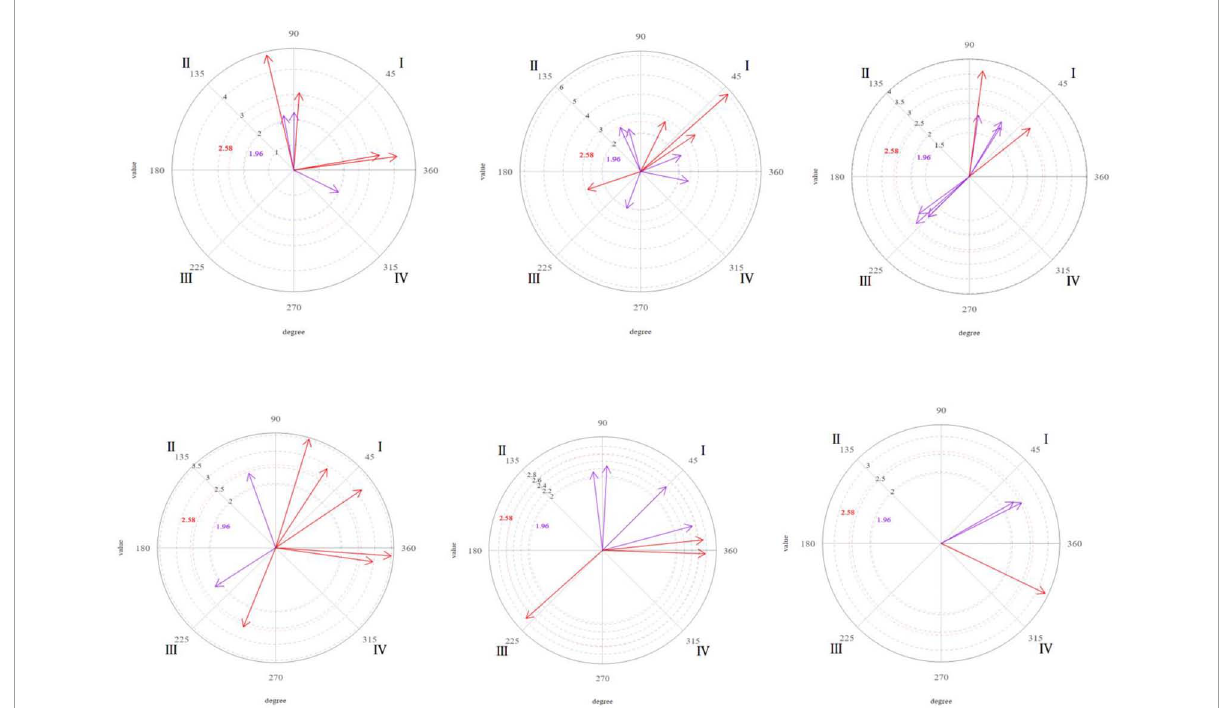
FIGURE1 Graphic representation of the significant (purple) and very significant (red) vectors obtained in the polar coordinate analysis. Focal behavior “Verbalizes” as the center of the analysis and all the others as conditional of sessions 9, 16, and 20 (from left to right). Focal behavior “Vocalizes” as the center of the analysis and all the others as conditional of sessions 9, 16, and 20 (from left to right).